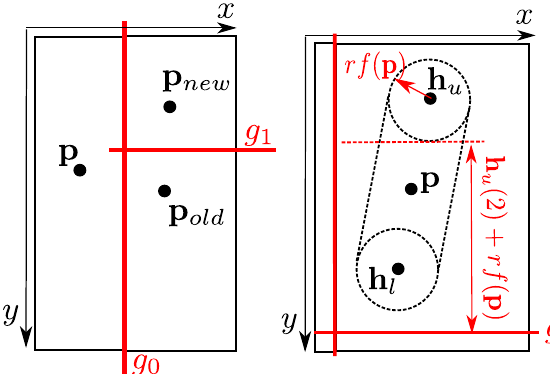
Figure 4: Left: Partitioning scheme of a KD-tree. Each node con- tains one point, nodes are divided by hyperplanes g i .